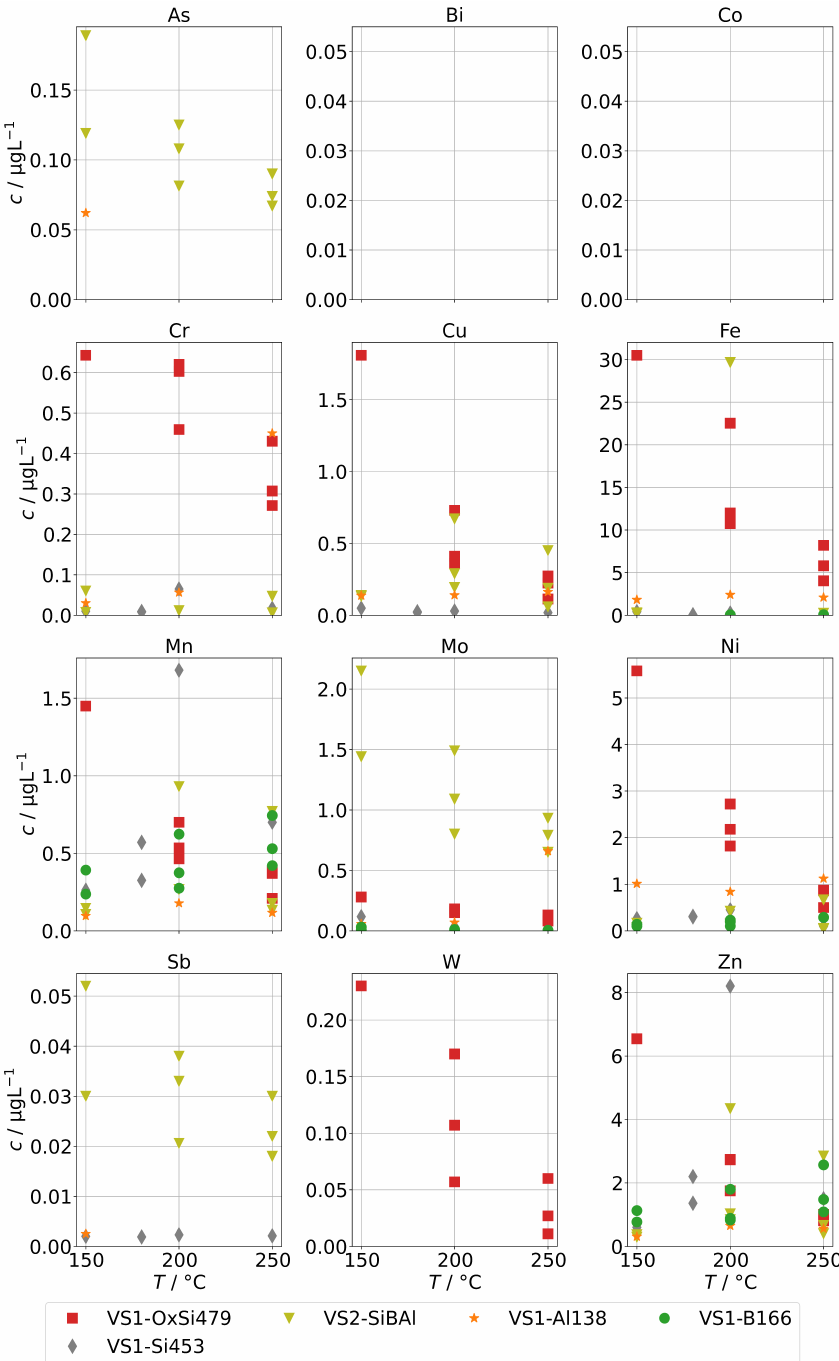
Figure 9. Concentrations of quantifiable species in condensates of the SB-SG obtained with spiked feed-water (group A) in dependence of operation temperature (no concentrations above limit of detection for Bi and